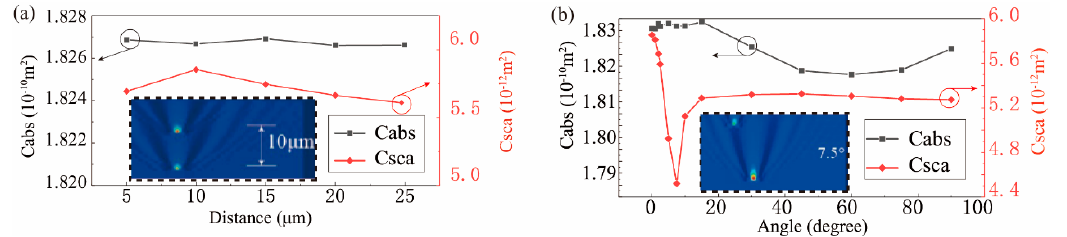
Figure 3. Simulation results for C sca and C abs . ( a ) Resulting curves for the case of different distances. ( b ) Resulting curves for the case of different angles.